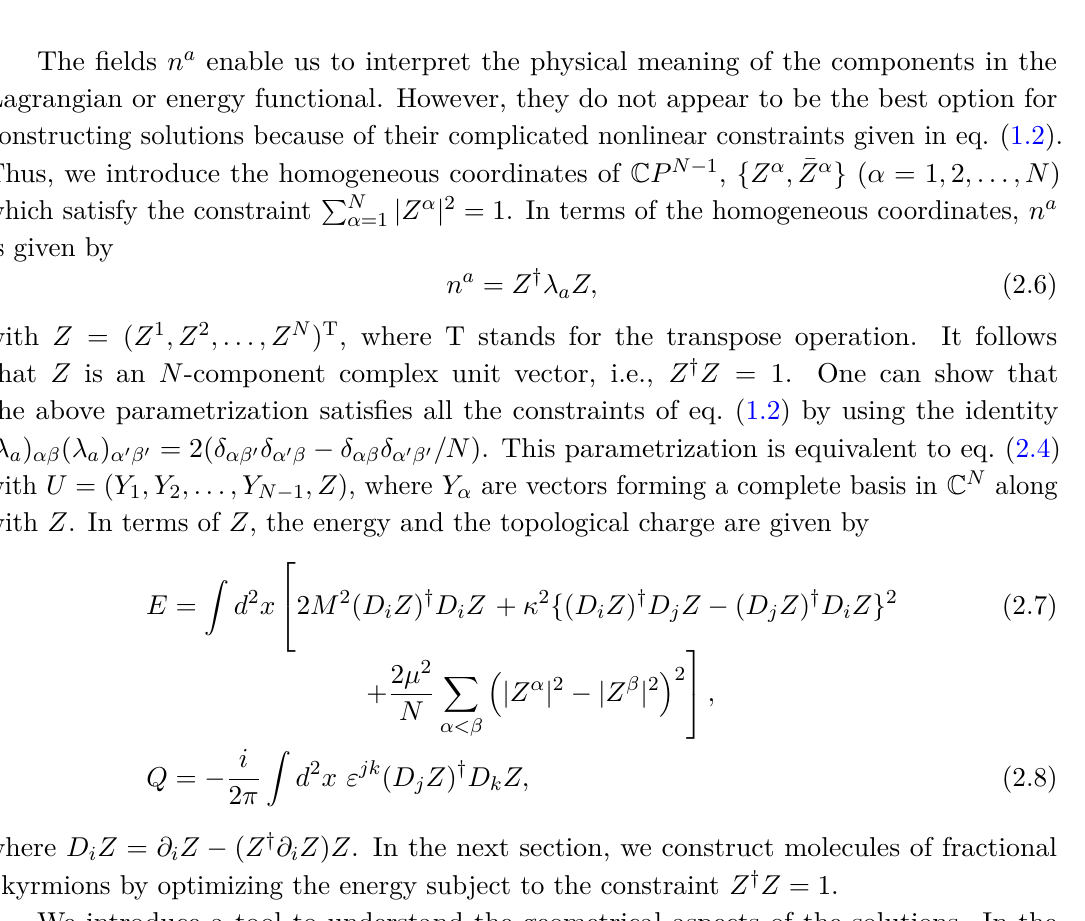
Figure 1 . Toric diagram of C P 2